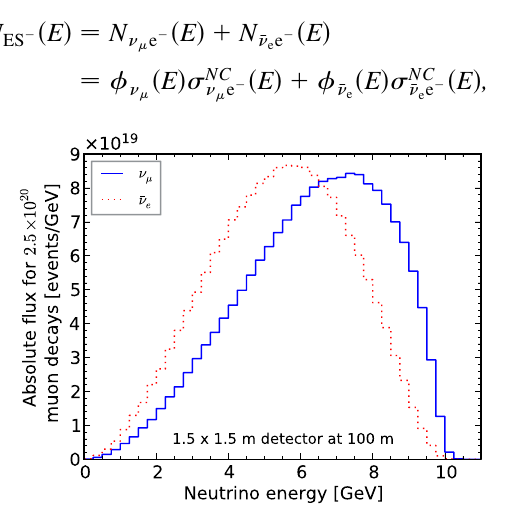
FIG. 17. Energy distributions of the (cid:5) (cid:3) and (cid:1) (cid:5) 10 GeV neutrino factory decay ring in (cid:3) (cid:1)